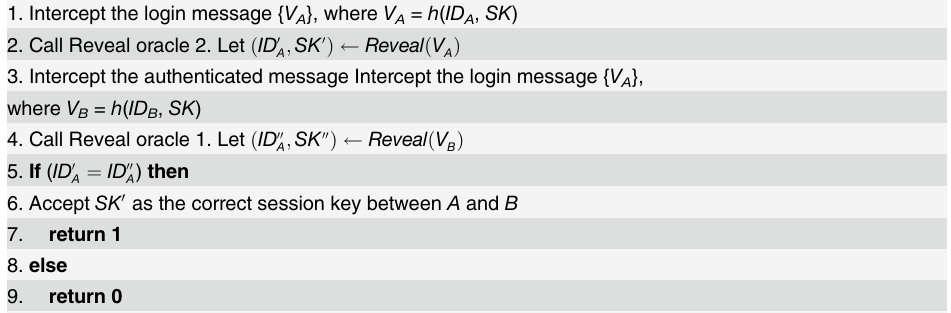
Table 2. Algorithm